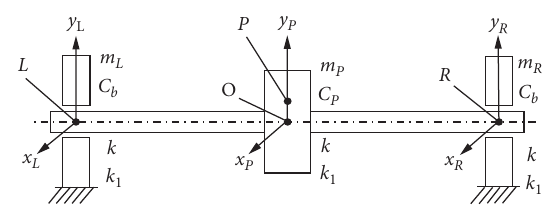
Figure 2: Schematic diagram of the rotor-bearing system. Table 1: Calculation parameters of the rotor